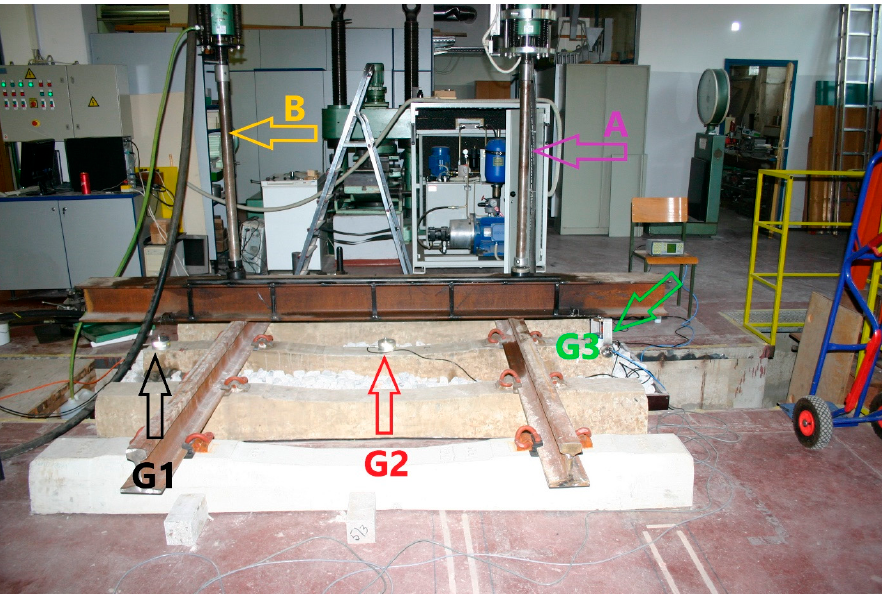
Figure 9. The location of the geophones labelled G1, G2 and G3. The arrow labelled B shows a static hydraulic piston with a capacity of 100 kN and the arrow labelled A shows a piston that was pulsed at a frequency of 1.5 to 2 Hz in the range between 20 and 100 kN. The results of the measurements with the Instantel Minimate Plus measuring equip- ment, which were the relative displacements of the measuring points in all three orthogonal directions and the resultant vibration velocity vector, are shown in Figures 10 and